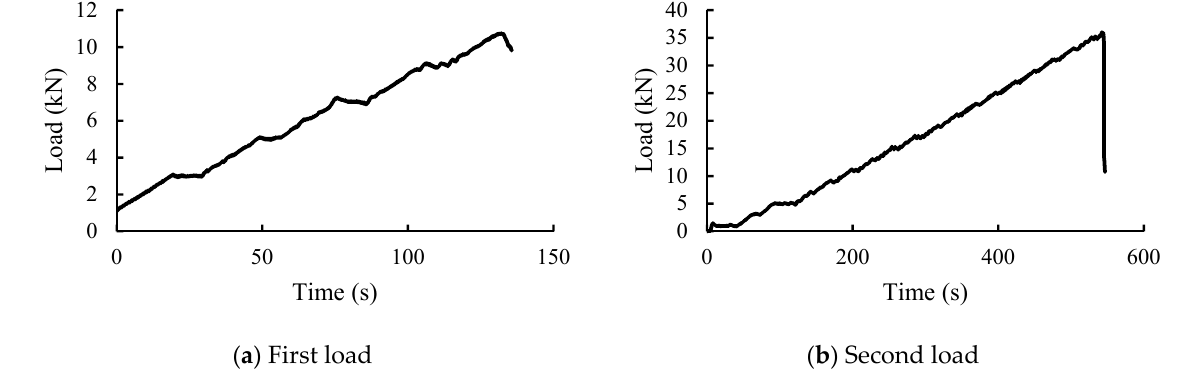
Figure 9. Loading curve of horizontal jack of Hc specimen. Table 2. The horizontal force of specimens with normal concrete contact surface.